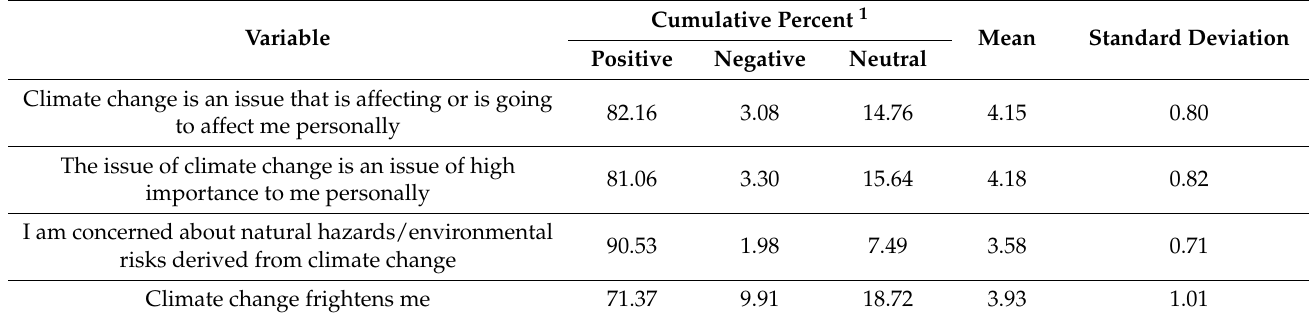
Table 4. Descriptive data on the questions regarding climate change risk perception.